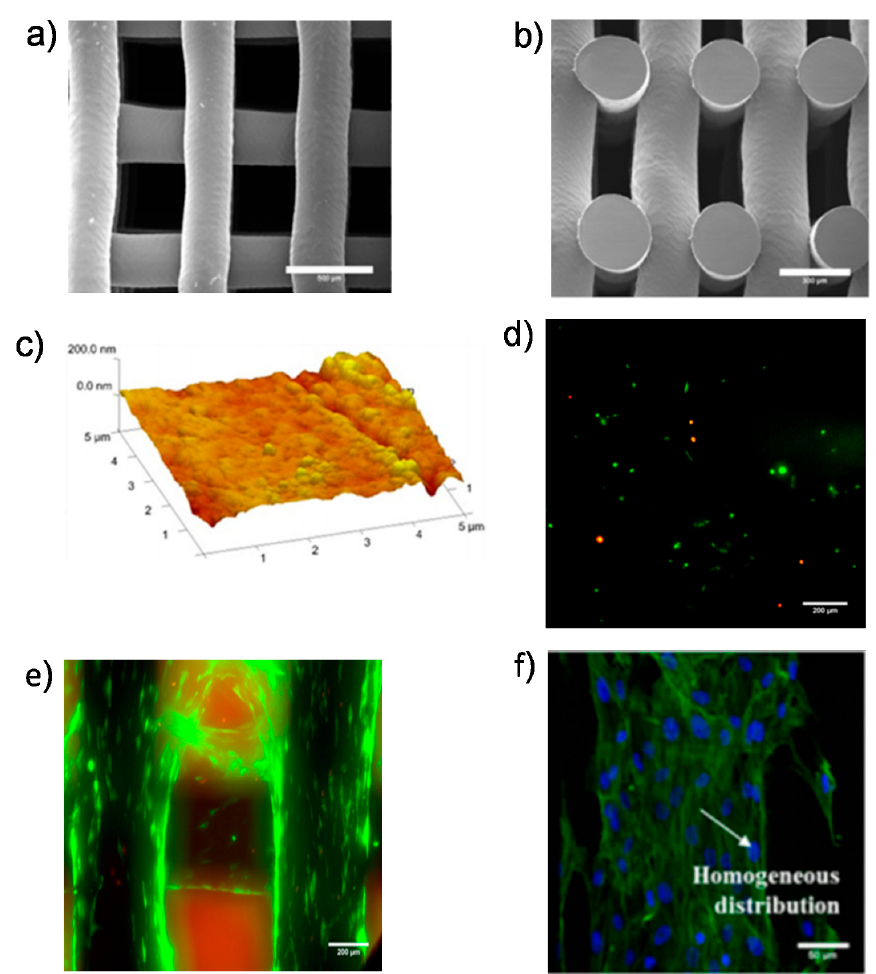
Figure 5. ( a ) SEM images showing the cell morphology of the polycaprolactone (PCL)–MWCNT sca ff old: ( a ) top-view (scale bar: 500 µ m) and ( b ) cross-section view (scale bar: 300 µ m); ( c ) AFM images showing the PCL–MWCNT sca ff old (scale bar: 5 µ m); live / dead assay at ( d ) day 1 (scale bar: 200 µ m) and ( e ) day 21 for the PCL–MWCNT sca ff old (scale bar: 200 µ m); ( f ) homogeneous distribution of cells on the surface of the PCL–MWCNT sca ff old (scale bar: 50 µ m). Reprinted with permission from